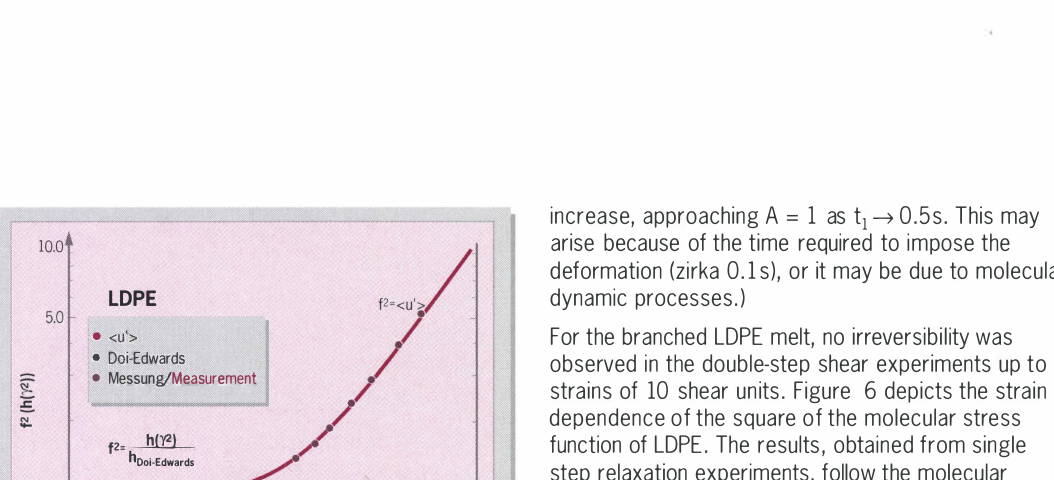
Fig. 6: f2 as a function